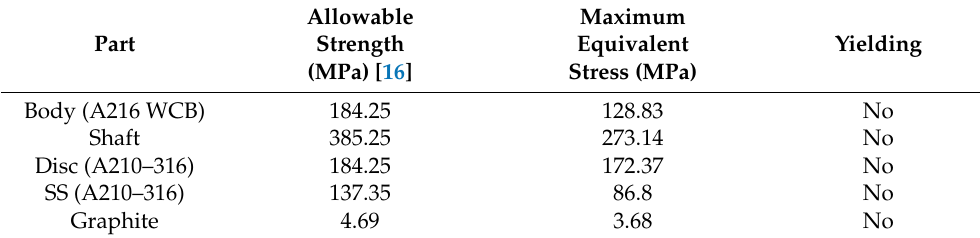
Table 6. The structural safety of the proposed QOBV.